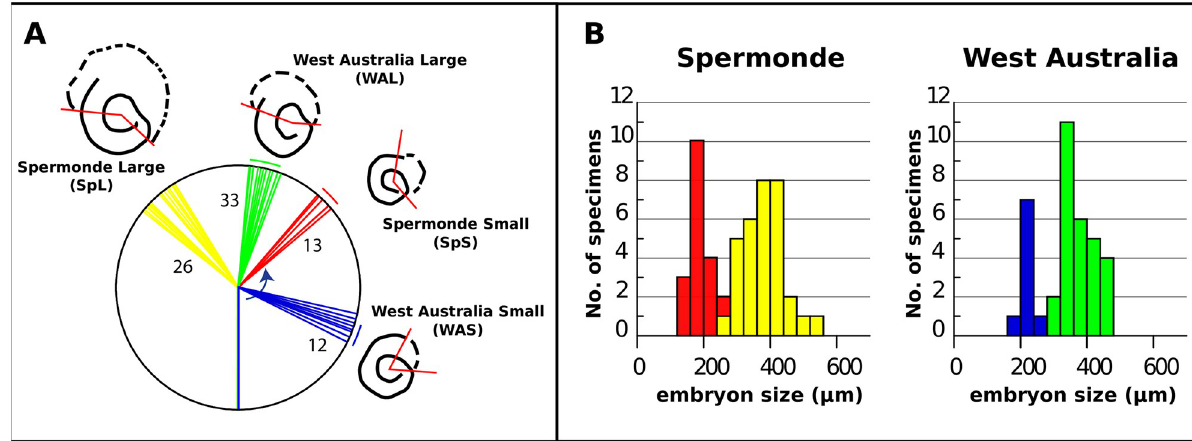
Fig 2. A) Variation in α (angle between the lines connecting the proximal intersect of the deuteroconch with the flexostyl) between the four Amphisorus morphotypes. Numbers indicate the number of analysed specimens B) Frequency diagram of the diameter of the embryonic apparatus (d in Fig 1) in Spermonde (A) and West Australia (B). Colors correspond to the